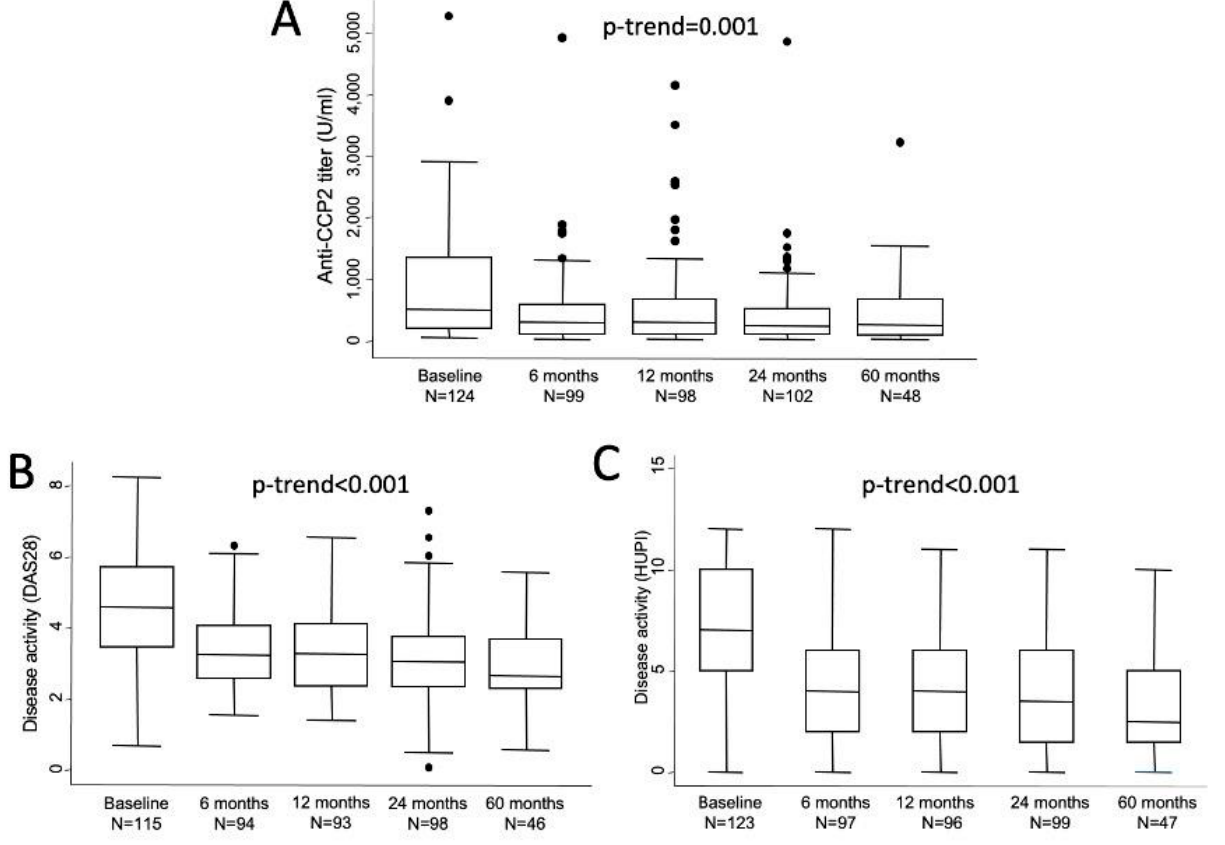
Figure 1. Evolution of anti-CCP2 titers ( A ) and disease activity assessed either with DAS 28 ( B ) or with HUPI ( C ). Data are shown as interquartile ranges (p75 upper edge of box, p25 lower edge, p50 midline) as well as the p95 (line above box) and p5 (line below). Dots represent outliers. Statistical significance was determined with the Mann-Whitney